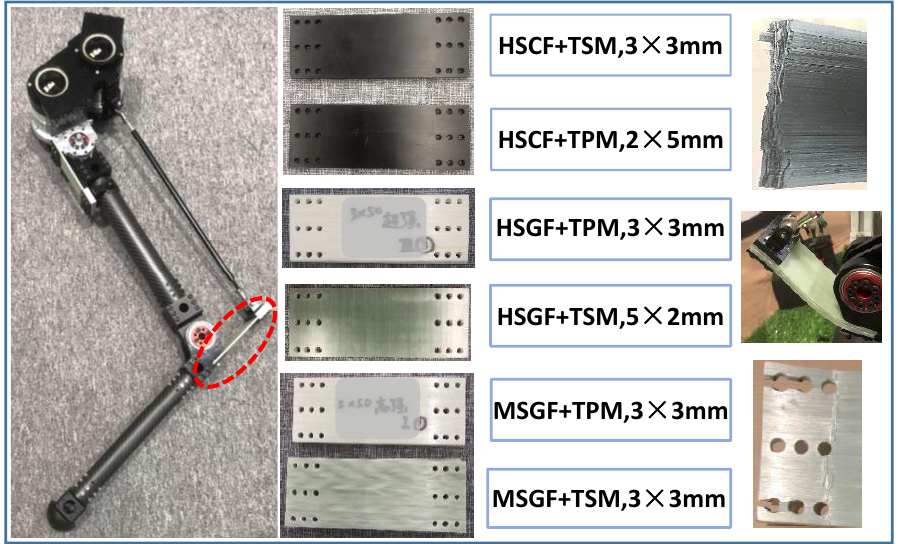
Figure 12. Failure of leaf springs made of different materials.